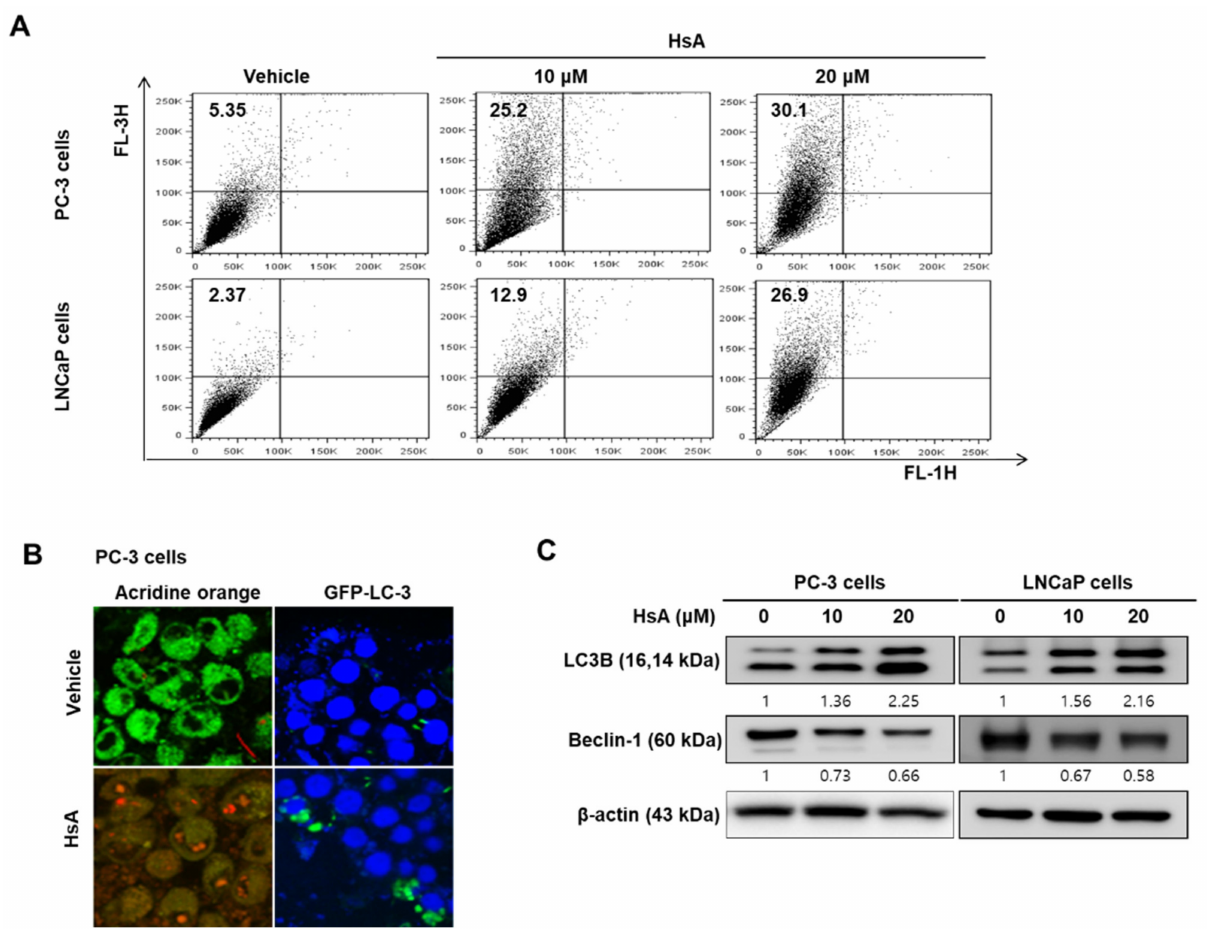
Figure 2. Hemistepsin A (HsA) induces autophagy in prostate cancer cells. ( A , B ) Acidic vacuoles’ detection: After treatment with HsA for 24 h, cells were stained with 1 µ M acridine orange (AO) for 20 min. Then, cells were analyzed by flow cytometry ( A ) and visualized using a laser scanning confocal microscope by AO staining ( B ). ( C ) LC-3 and Beclin-1 expression: After treatment with HsA, total cell lysates were subjected to SDS-PAGE for western blot